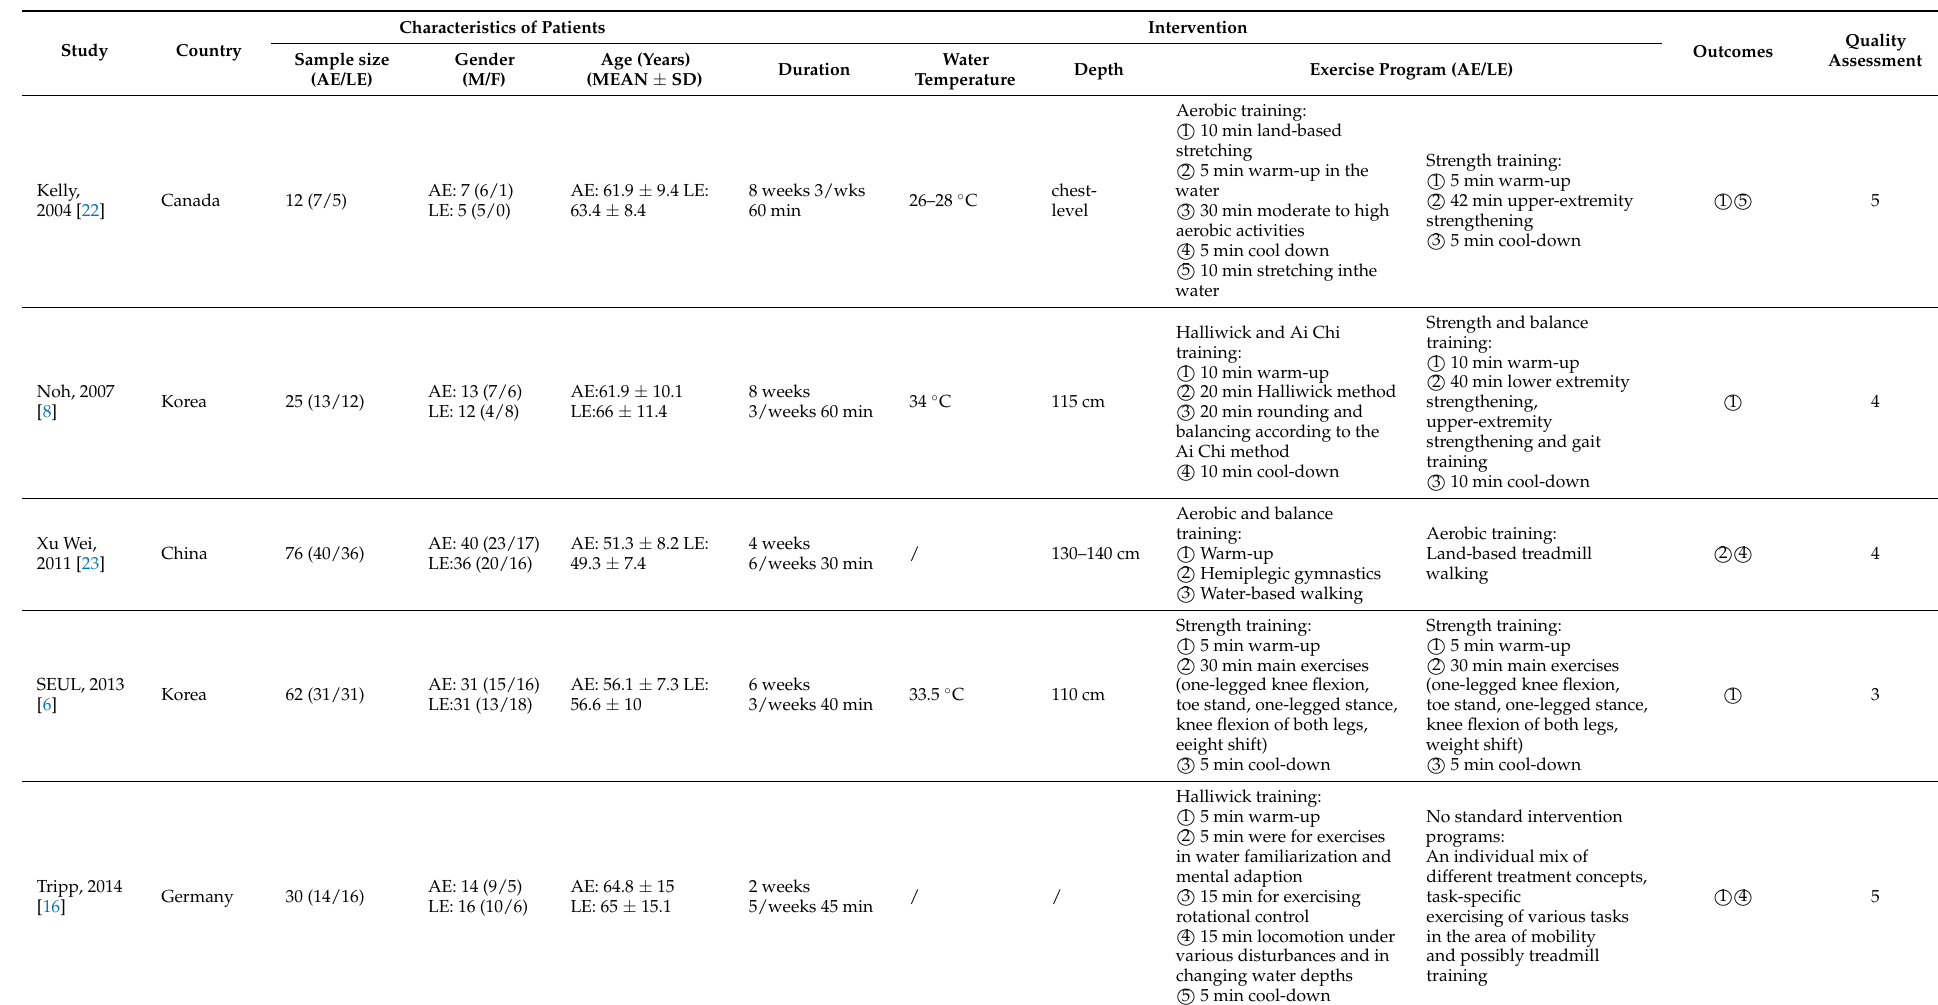
Table 2. Characteristics of the studies included in the